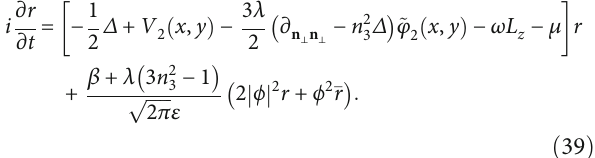
ffiffiffi ffiffiffi p p 5 , n = ð 1,0,1 Þ / 2 ,